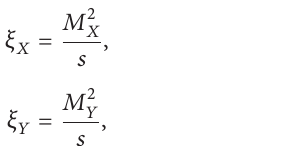
Figure1:Illustrationofasingle(top)anddouble(bottom)diffractivedissociativeeventinwhichaPomeron( P )isexchangedinappcollision. 𝑀 𝑀 𝑋 and 𝑌 are the invariant masses of the dissociation systems is the mass of the intact proton. Δ𝜂 refers to the size of the large rapidity